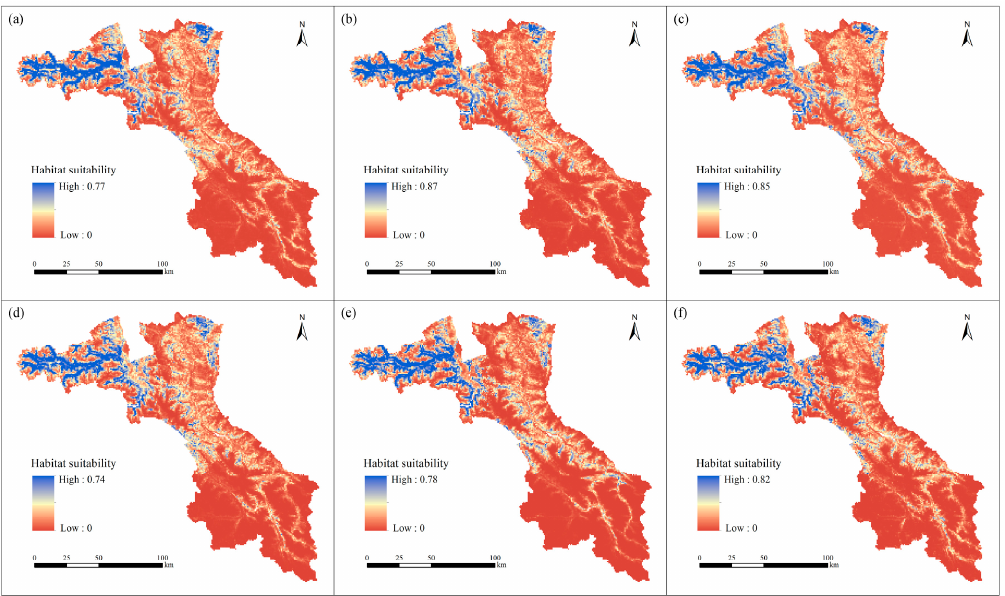
Figure 3. The habitat suitability of Siberian ibex in Taxkorgan Nature Reserve under three greenhouse gas emissions scenarios for two periods; top panel predictions for 2050 and bottom panels for 2070. ( a ) RCP 2.6 for 2050; ( b ) RCP 4.5 for 2050; ( c ) RCP 8.5 for 2050; ( d ) RCP 2.6 for 2070; ( e ) RCP 4.5 for 2070; ( f ) RCP 8.5 for 2070.